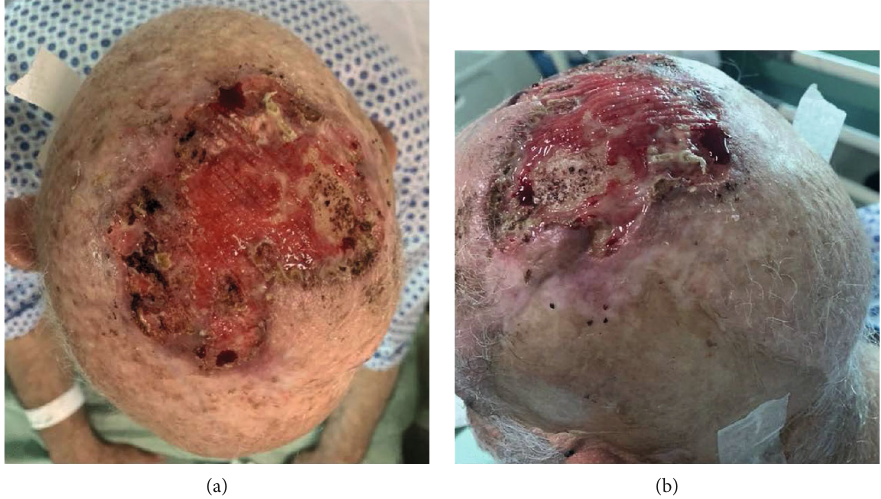
Figure 1: (a, b) Massively ulcerated basal cell carcinoma of the